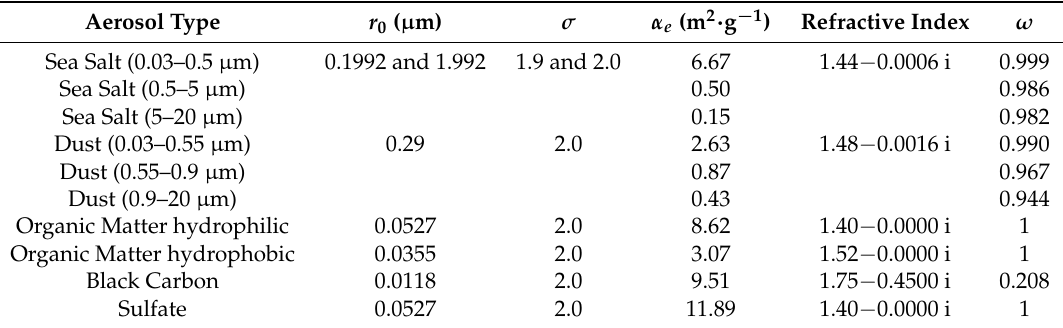
Table 2. CAMS (Copernicus Atmosphere Monitoring Service) aerosols optical properties at 550 nm and 80% relative humidity (RH). r 0 is the modal radius, σ is the geometric standard deviation, α e is the mass extinction coefficient and ω is the single scattering